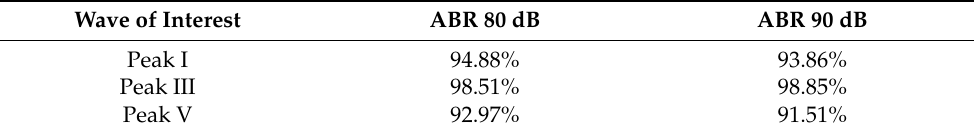
Table 3. Validation of the ABR automated annotation tool. Wave of